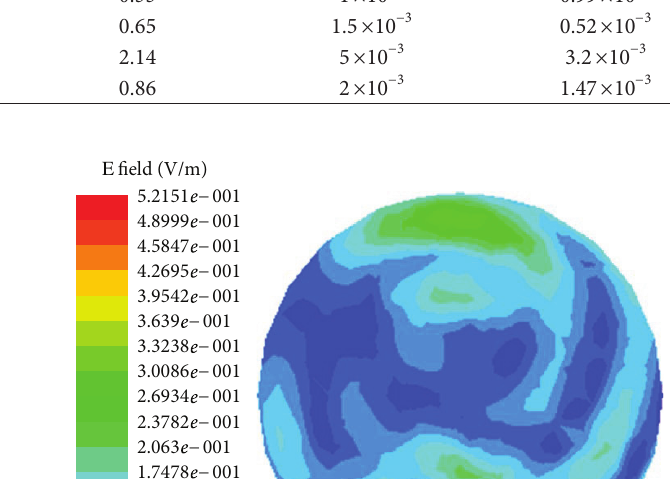
Six layers + PIFA